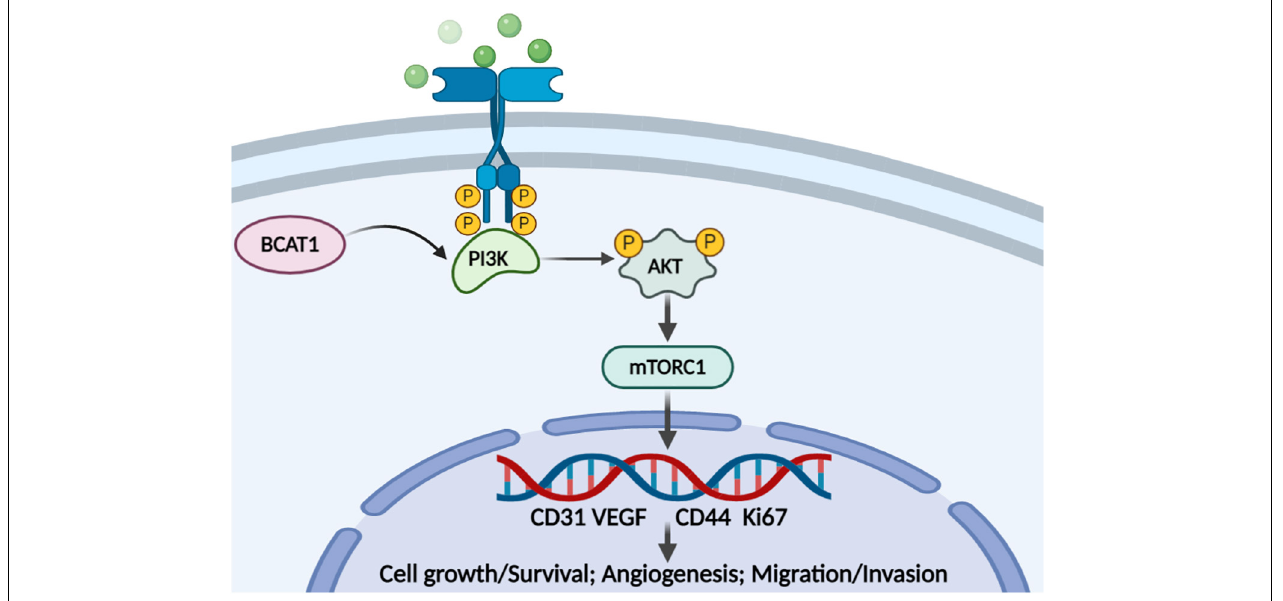
FIGURE 6 | Proposed model for the role of BCAT1/PI3K/AKT/mTOR axis in regulating GC angiogenesis and